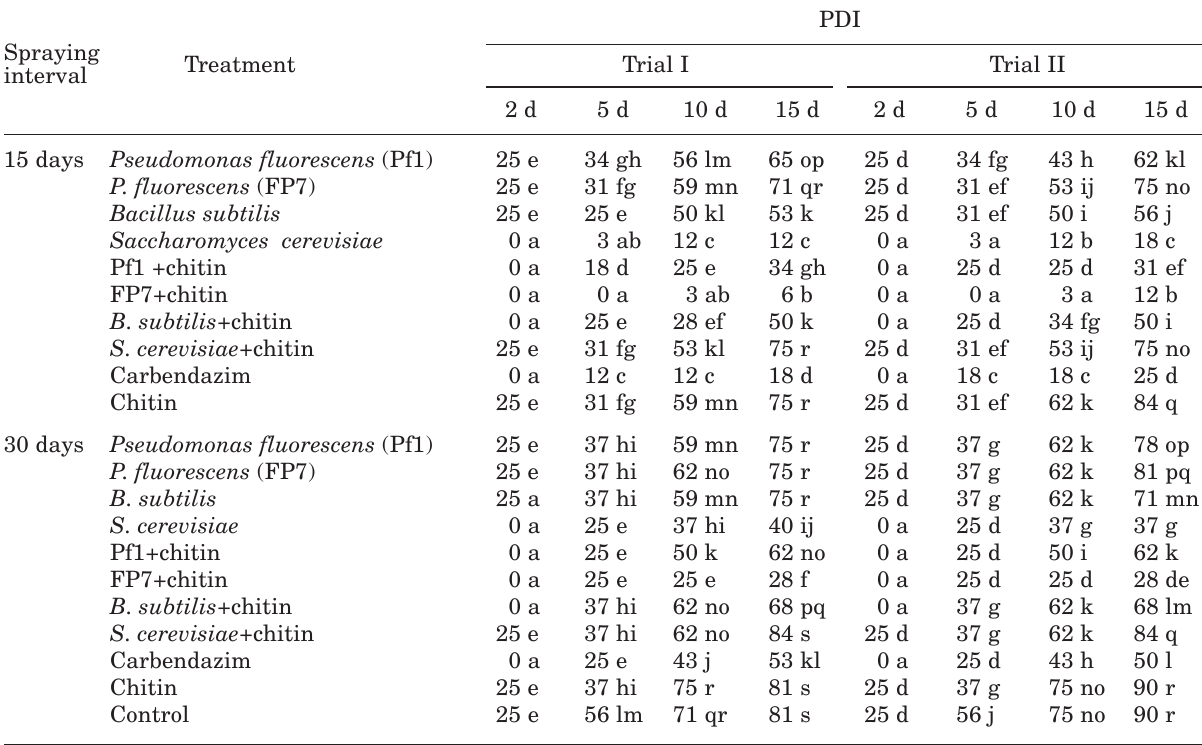
Table 2. Efficacy of pre-harvest application of biocontrol formulations on latent symptom development in mango fruits under stored conditions (28±2°C) as percent disease index (PDI) 2, 5, 10, 15 days after